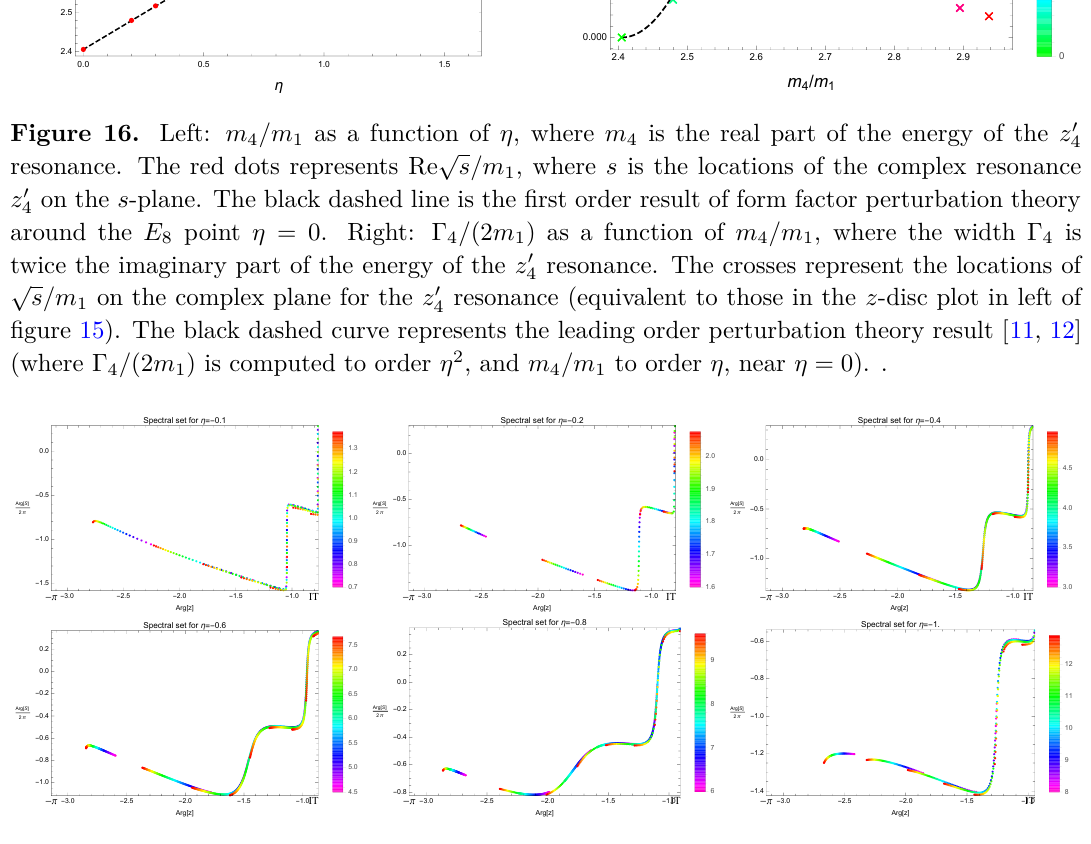
Figure 17. Spectral sets for the elastic scattering phase, computed from TFFSA with truncation level L =21 over a range of cylinder radii (indicated by color), for some η values between − 1 and 0